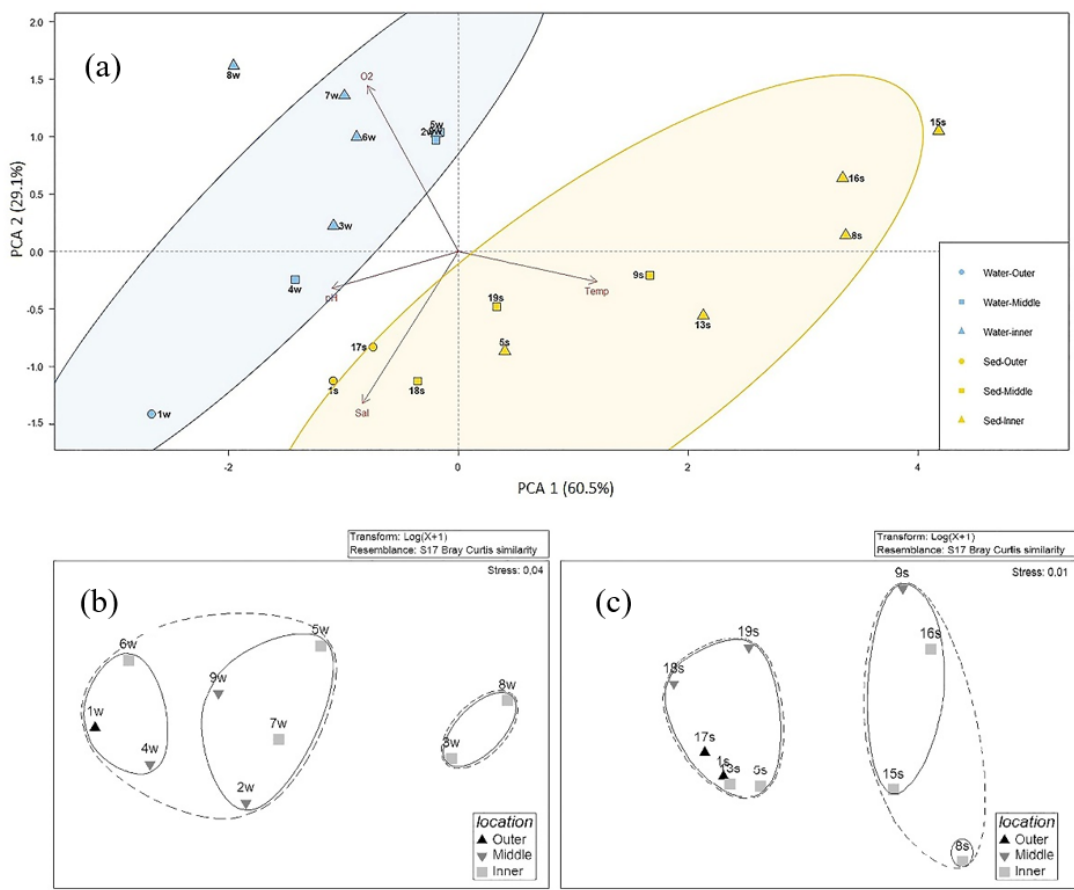
Figure 5. Principal Component Analysis (PCA) analysis on the distribution of water (blue) and sediment (yellow) samples in relation to oxygen, temperature, salinity, and pH in water (blue) and sediments (yellow). The two ellipses include samples with a similarity > 75% ( a ), nMDS analysis computed on abundance values at genus level detected in water ( b ), and sediment samples ( c ).